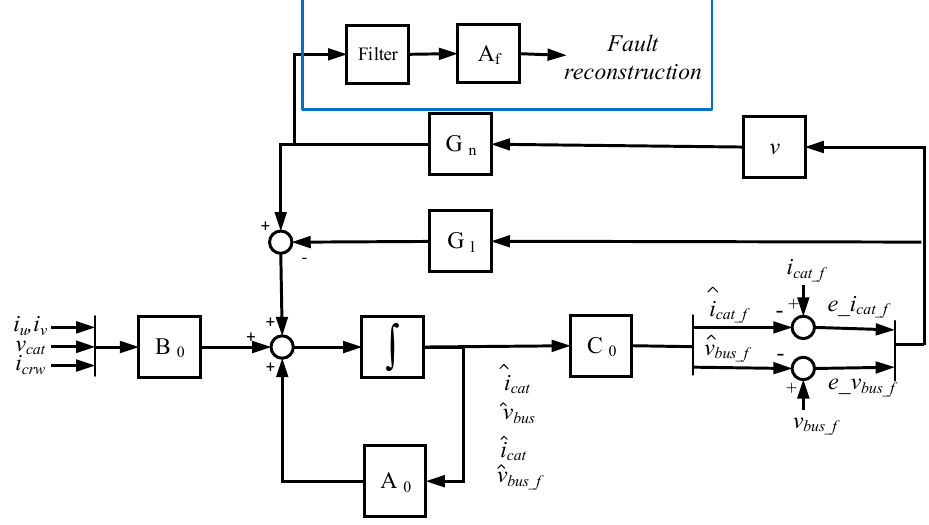
Figure 4. Sensor fault reconstruction based on the sliding mode observer (SMO).